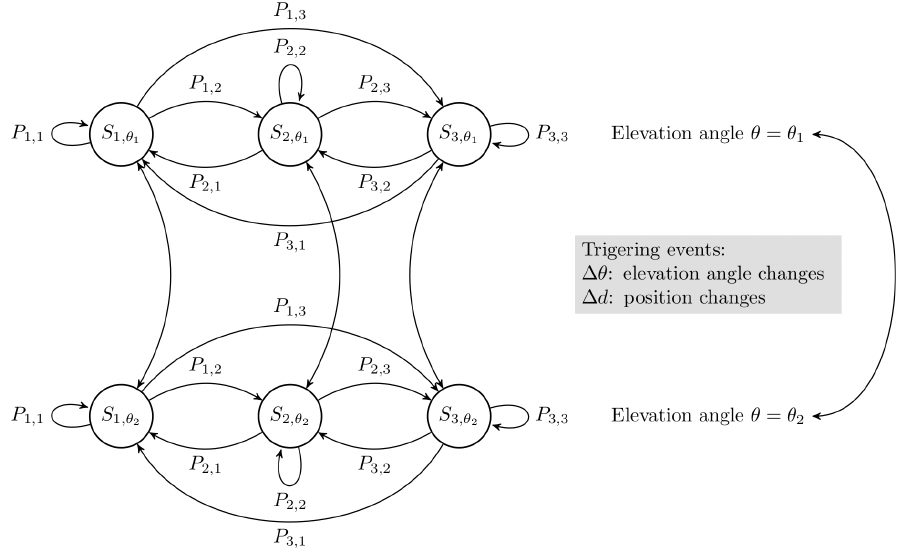
Figure 5. Generalization of a three-state channel model as proposed by [24] considering state transitions based on elevation angle changes.